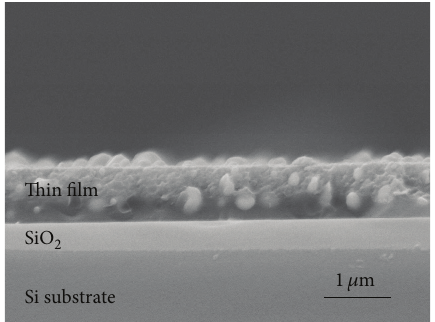
Figure 4: The cross section micrograph of the as-annealed AFCN thin